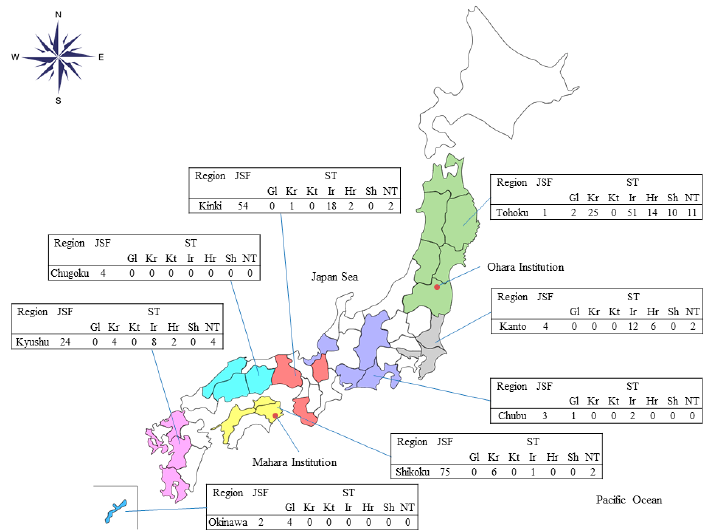
Figure 3. The number of cases serologically diagnosed as Japanese spotted fever or scrub typhus (serotypes) in each Japanese region at the reference centers. Abbreviation: JSF, Japanese spotted fever; ST, scrub typhus; Gl, Gilliam; Kr, Karp; Kt, Kato; Ir, Irie/Kawasaki; Hr, Hirano/Kuroki; Sh, Shimokoshi; NT, non-typeable; Ohara Institution, Ohara Research Laboratory, Ohara General Hospital; Mahara